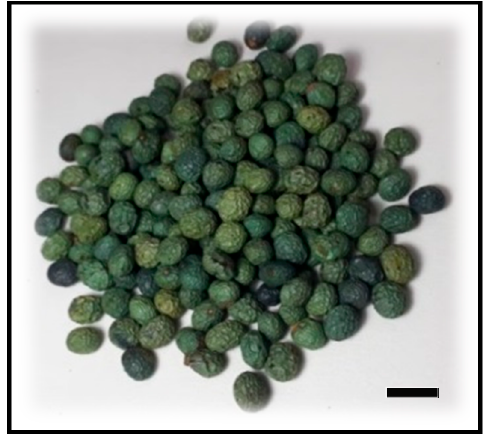
Figure 1. The seeds of Pistacia khinjuk Stocks. Bar: 0.90